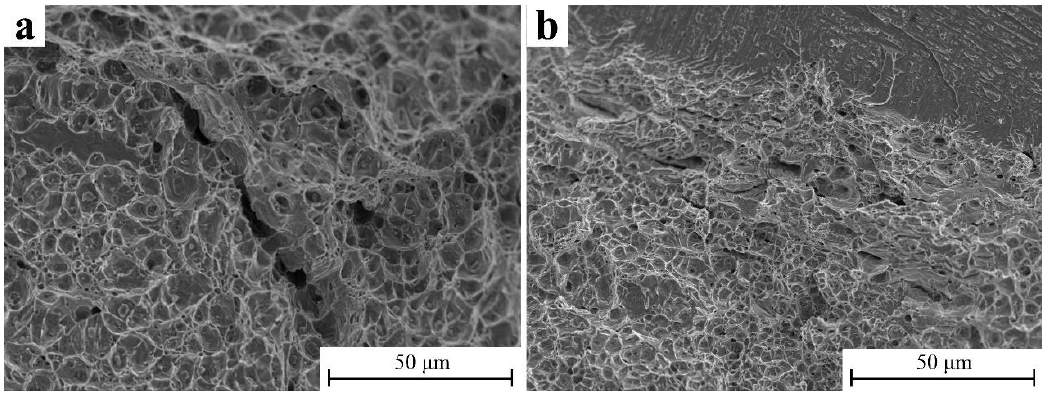
Figure 9. Scanning electron microscopy (SEM) images of the tensile fracture in the ( a ) Y and ( b ) Z direction.